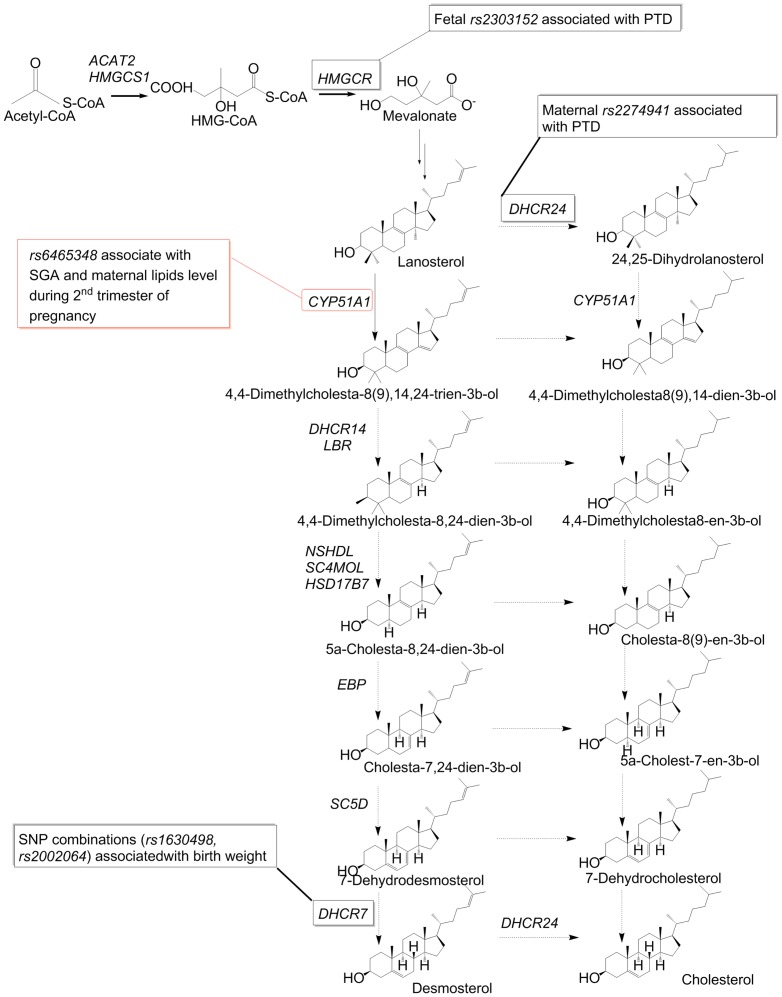
Cholesterol biosynthesis pathway with genes associated with preterm delivery and low birth weight according to Steffen at all [7] and with input from our study.